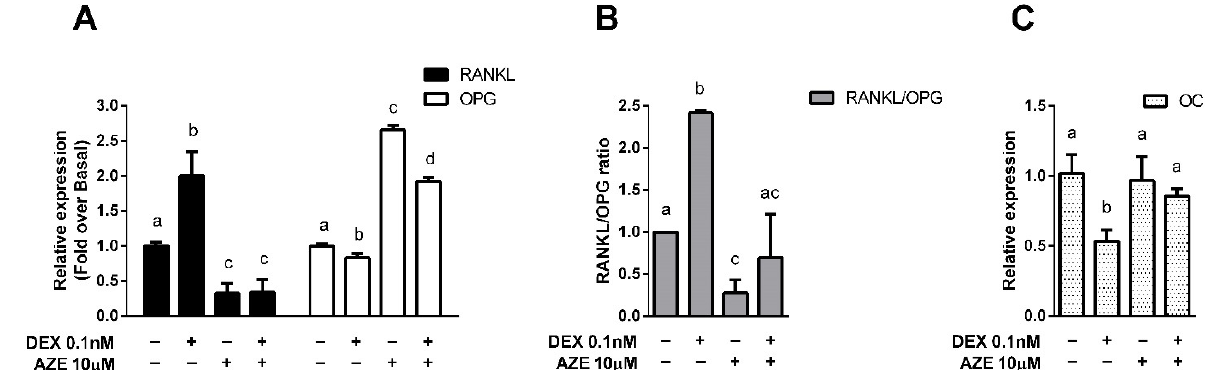
Figure 5. Azelastine counteracts dexamethasone-induced modulation of bone metabolism marker genes. MC3T3-E1 pre-osteoblastic cells differentiated to osteoblasts were exposed for 10 min to 10 µ M azelastine (AZE) and then treated with 0.1 nM dexamethasone (DEX) for 3 h. ( A , B ) Receptor activator of nuclear factor kappa-B ligand (RANKL), osteoprotegerin (OPG), and ( C ) osteocalcin (OC) mRNA levels were quantified by qPCR as described in the methods section. Results are mean +/ − SD of at least three independent experiments performed in triplicates. Statistical significance was denoted using letters above bars. Means indicated with a common letter are not significantly different. Likewise, means not sharing any letter are significantly different.